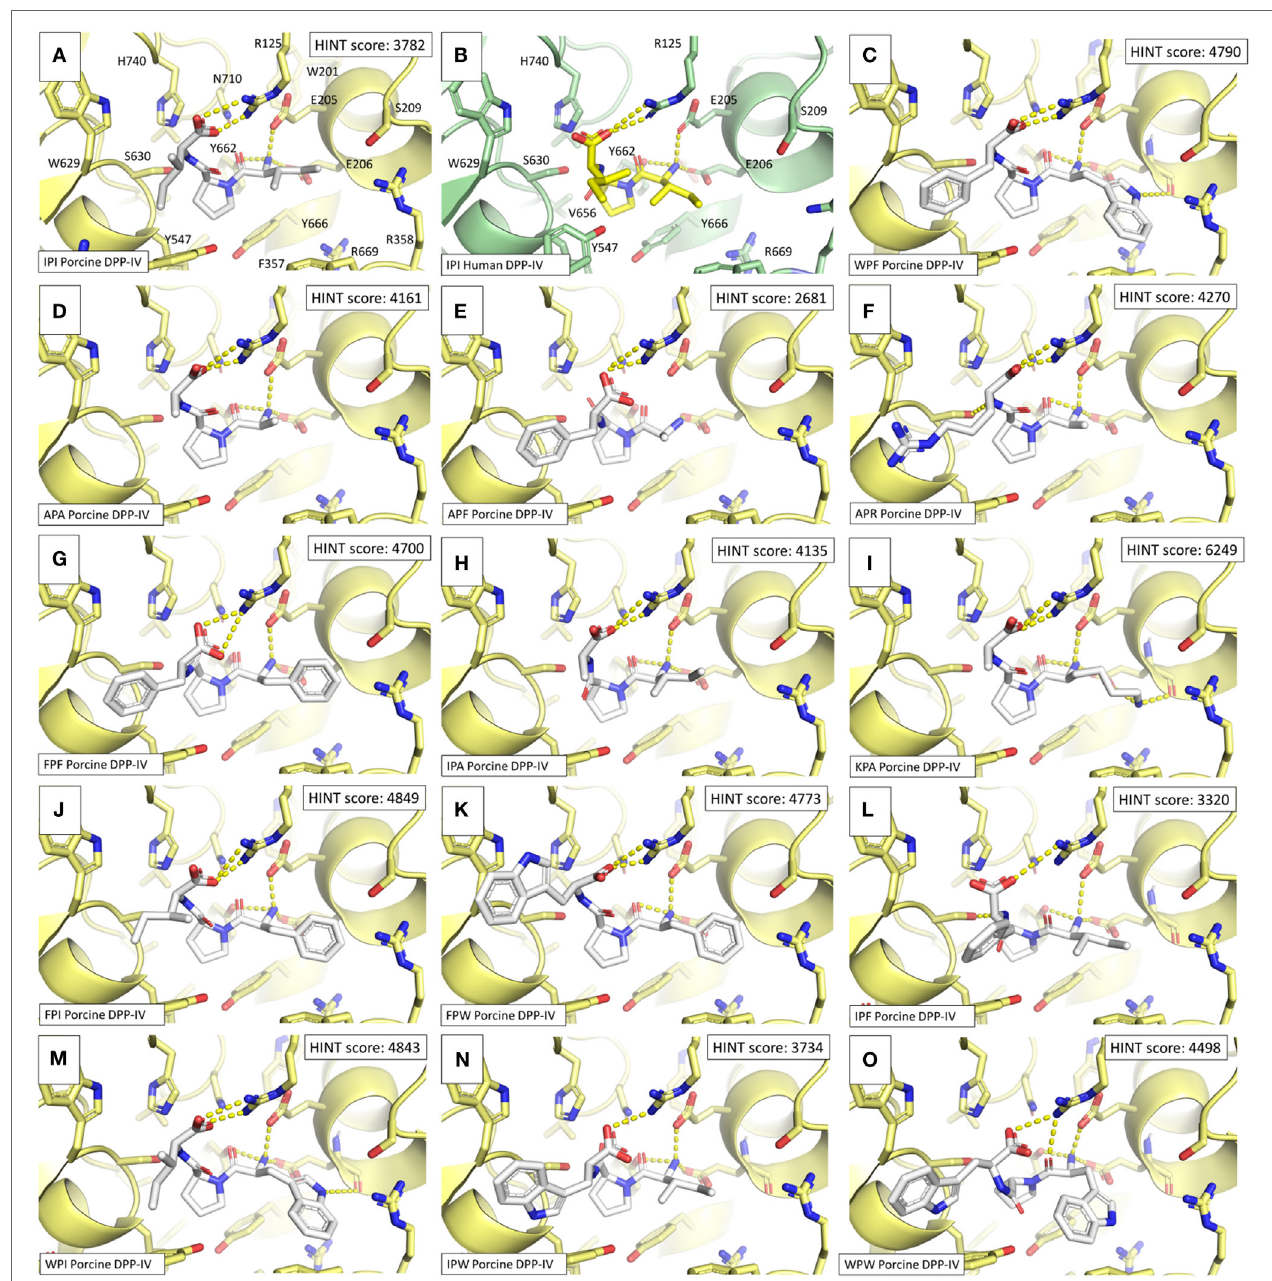
FigUre 6 | Binding architectures of dipeptidyl peptidase IV (DPP-IV) inhibitory peptides. The protein is represented in cartoon while peptides and amino acid side chains are represented in sticks. Yellow dotted lines indicate the protein–peptide polar interactions. (a) Ile-Pro-Ile. (b) Crystallographic pose of Ile-Pro-Ile within human DPP-IV [PDB structure 1WCY (37)]. (c) Trp-Pro-Phe. (D) Ala-Pro-Ala. (e) Ale-Pro-Phe. (F) Ala-Pro-Arg. (g) Phe-Pro-Phe. (h) Ile-Pro-Ala. (i) Lys-Pro-Ala. (J) Phe-Pro-Ile. (K) Phe-Pro-Trp. (l) Ile-Pro-Phe. (M) Trp-Pro-Ile. (n) Ile-Pro-Trp. (O)